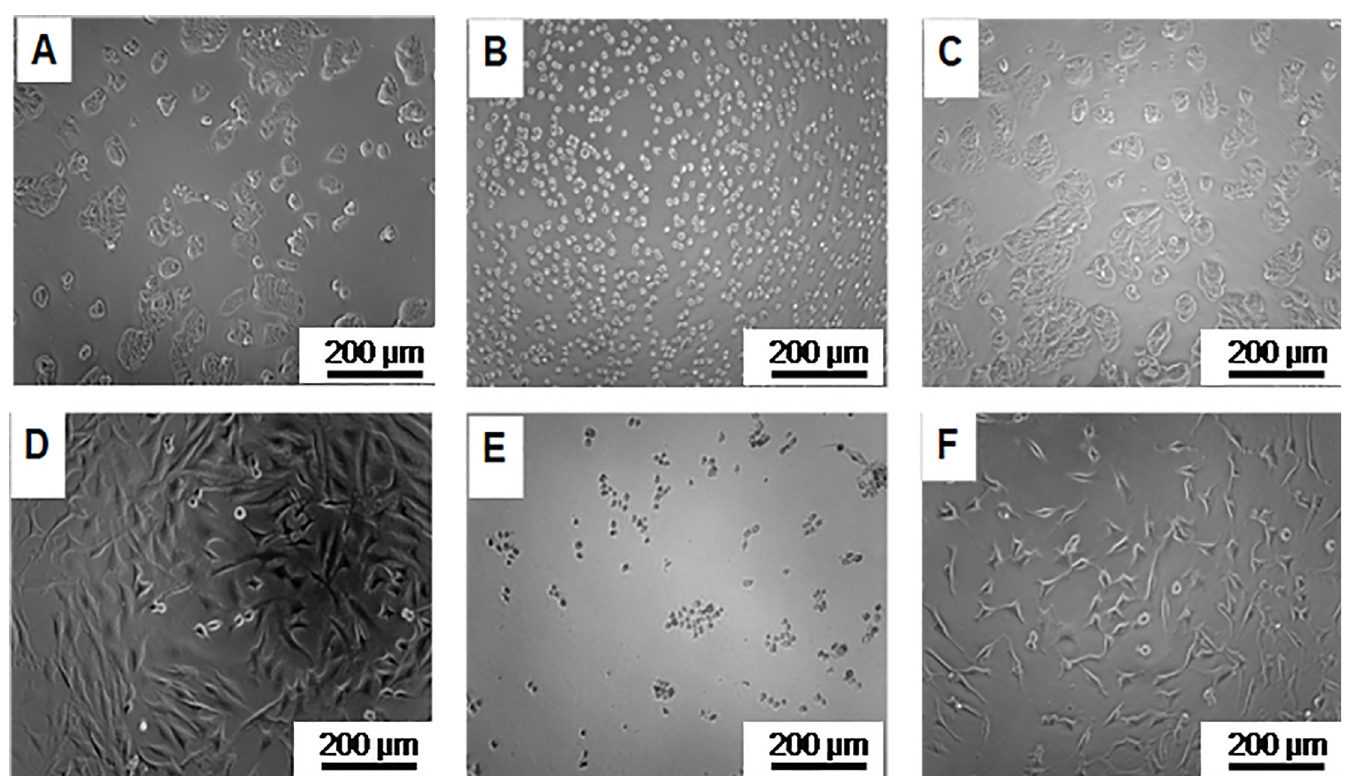
Fig 6. Micrographs of HT-29 (A-C) and Hela (D-F) cells without treatment (A, D), or incubated for 5 mins in PEG6000 from C.E. (B, E) and S.A. (C, F) and imaged 48 h after seeding. The scale bars indicate 200 μ m.